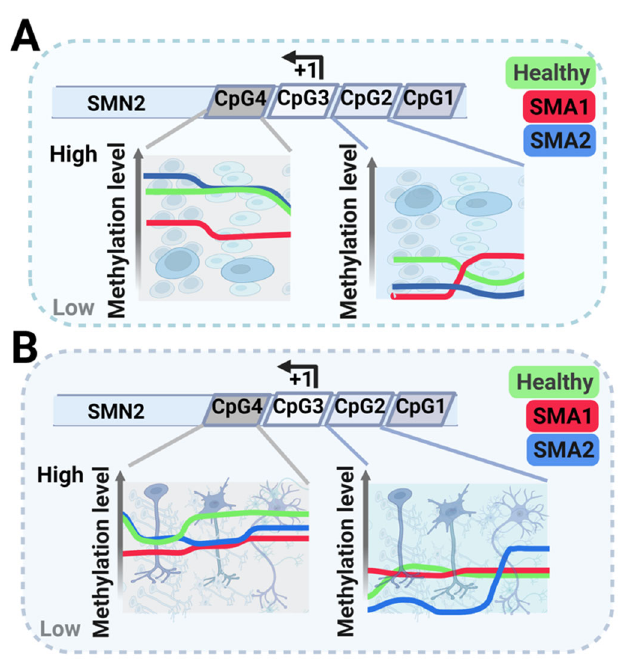
Figure 1. Schematic representation of methylation levels in the survival of motor neuron 2 ( SMN2 ) gene at various differentiation stages during motor neuron (MN) development: induced pluripotent stem cells (iPSCs), neuroepithelial precursors (NEP) in panel ( A ), immature MNs (IMN), and mature MNs (MMNs) in panel ( B ). Green represents healthy individuals, blue represents SMA2 patients, and red represents SMA1 patients. The scheme also describes methylation in the SMN2 gene’s four different CpG